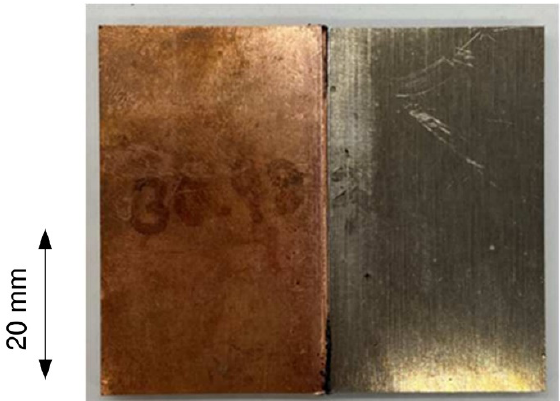
( b ) Figure 12. SEM-EDX analysis of joint boundary (left: C1100, right: A6061): ( a ) SEM image and line scan result; ( b ) Magnified view of central part. 4.2. Joining Using Shaved Surface The joining of C1100 and A6061 was investigated. An example of the joined plates is shown in Figure 13. The cross-sections are shown in Figure 14 for two different overlap lengths. Comparing these cross-sectional profiles with those in Figure 5c, the shear droop